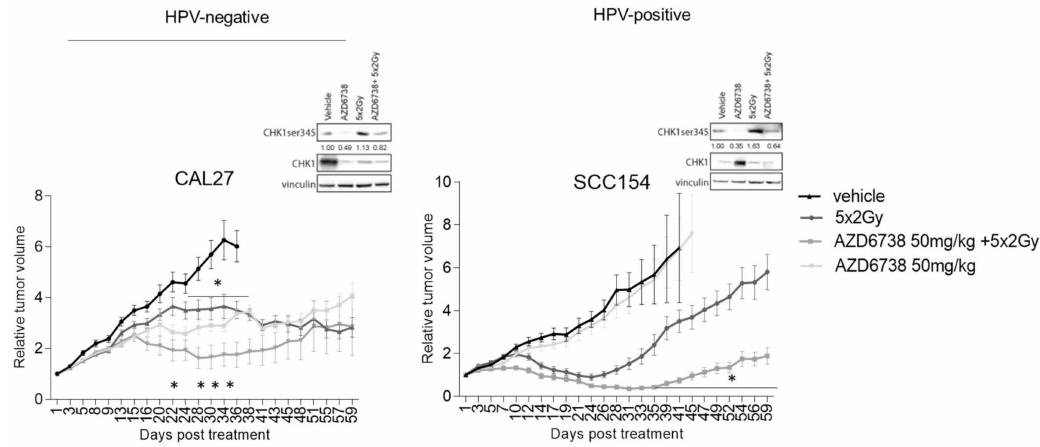
Figure 7. Effect of ATR inhibition on RT response of HPV-negative and HPV-positive HNSCC xenografts. Relative tumor volume curves of HPV-negative CAL27 and HPV-positive SCC154 xenografts treated with vehicle (10% DMSO/40% propylene glycol) or AZD6738 (50 mg/kg) with(out) RT (5 × 2Gy). Relative tumor growth curves were normalized to the tumor volume at the start of treatment Day 1. Day 1 indicates the start of treatment. Data are presented as mean ± s.e.m, n = 10. * p -value < 0.05 were determined by two-way ANOVA with Bonferroni correction for multiple testing. Western blot analysis of xenograft samples of the HPV-negative CAL27 model (left) and the HPV-positive model SCC154 (right) show the effect of ATR inhibition on CHK1 activation. Tumors for Western blot analysis were harvested at the evening of the last treatment day per schedule. CHK1ser345 (51 kDa), CHK1 (51 kDa), and vinculin (97 kDa) antibodies were used for immunoblotting. N = tumors; kDa = molecular weight as determined by the protein